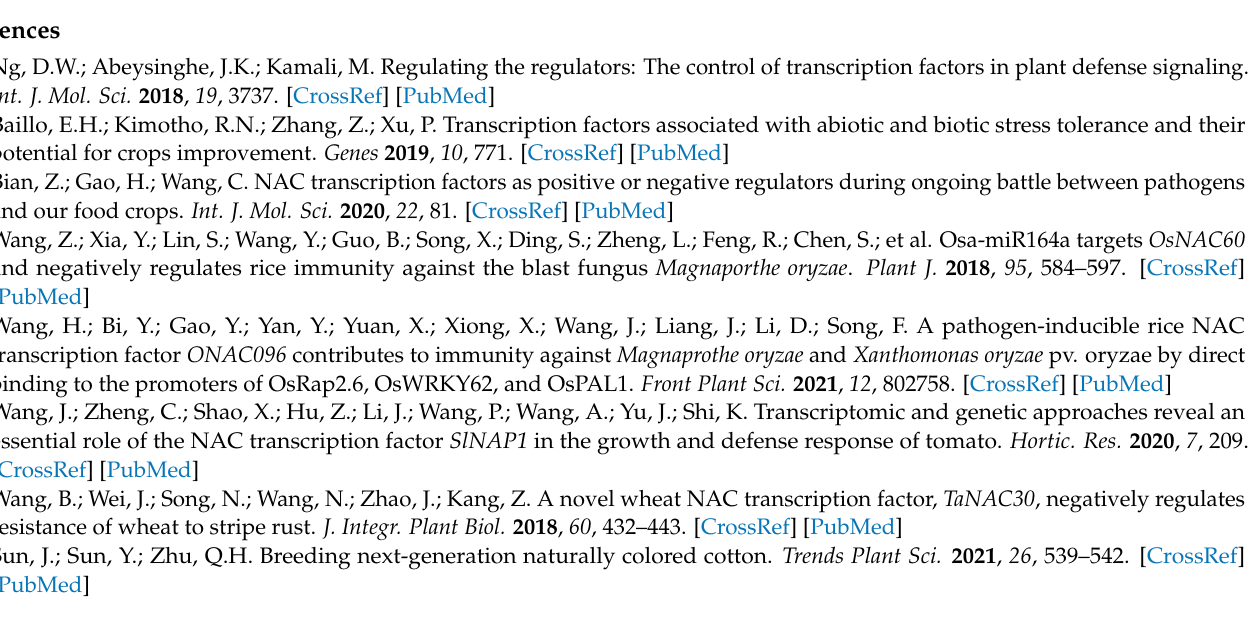
Figure S3: Cis-element analysis of DEGs in putative GhNACs’ promoters. Different cis-elements with the same or similar functions are shown in the same color. Table S1: The GhNAC gene family in G. hirsutum L. Table S2: Segmental and tandem duplications of GhNAC gene pairs. Table S3: Summary of transcriptome sequencing results after filtering. Table S4: GhNACs differentially expressed in J11 and Z2. Table S5: Primers used in the